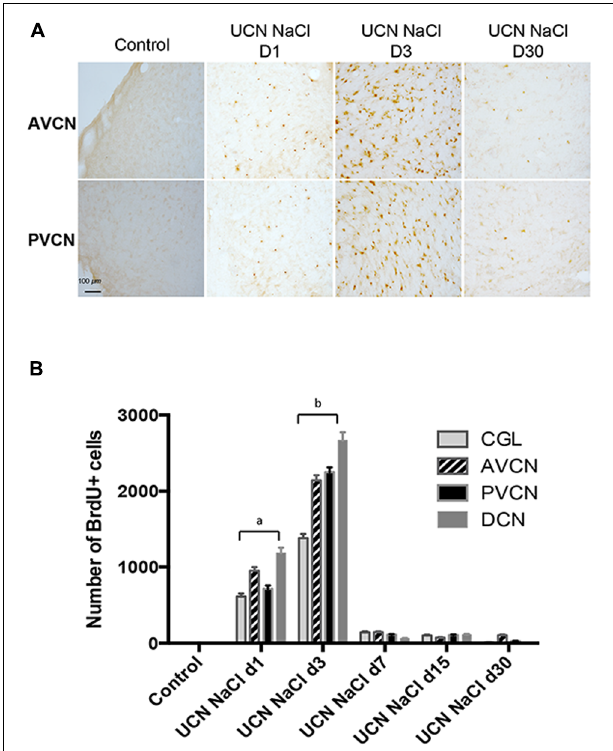
FIGURE 2 | Reactive cell proliferation occurs after unilateral cochlear neurectomy (UCN) in a time-sensitive manner. (A) Photomicrographs showing 5-bromo-2 (cid:48) -deoxyuridine (BrdU) immunostainings in the deafferented cat AVCN and PVCN submitted to UCN and analyzed at post-lesion days 1, 3, and 30 (D1, D3, and D30, respectively). Animals received a BrdU injection (i.p., 200 mg/kg body weight) 3 h before sacrifice. Scale bar: 100 µ m for lower magnification. (B) Quantitative evaluation. Histograms comparing the mean values ( ± Standard Error of the Mean, SEM) of the number of BrdU-immunopositive cells in the deafferented CN at D1, D3, and D30 after UCN. Different letters indicate significant differences between groups of animals and assessed by ANOVA followed by the Scheffé test, p < 0.0001, see Table 1 . a: significantly different from control, UCN d3, UCN d7, UCN d15, and UCN d30 groups. b: significantly different from control, UCN d1, UCN d7, UCN d15, and UCN d30 groups. Only values recorded on the lesioned side are illustrated. n = 4 animals per group.